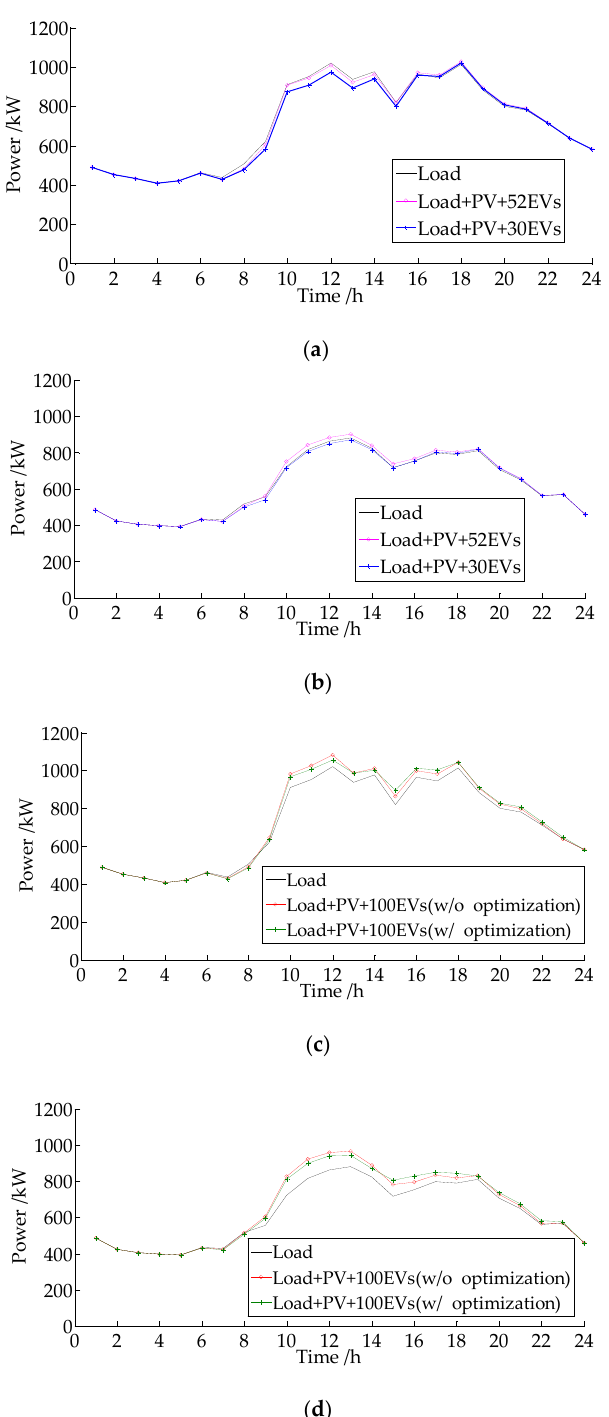
Figure 12. Simulations of EVs charging for each weather type. ( a ) Simulation results on sunny day with 30 and 52 EVs; ( b ) simulation result on rainy day with 30 and 52 EVs; ( c ) simulation results on sunny day with 100 EVs; ( d ) simulation results on rainy day with 100 EVs.